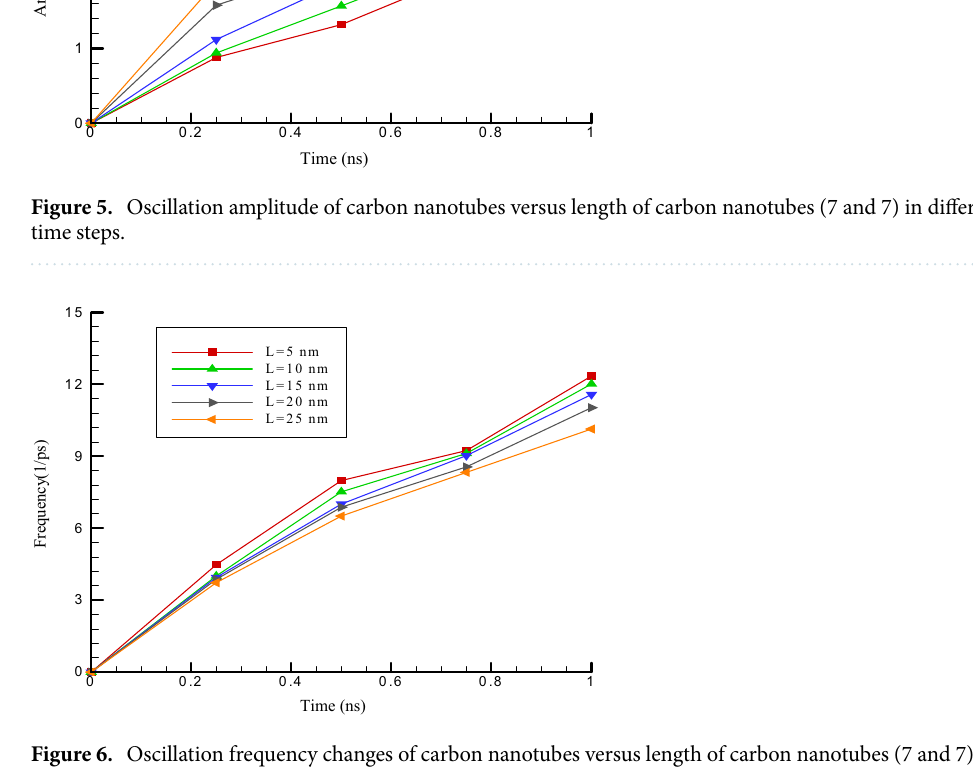
Length of carbon nanotubes